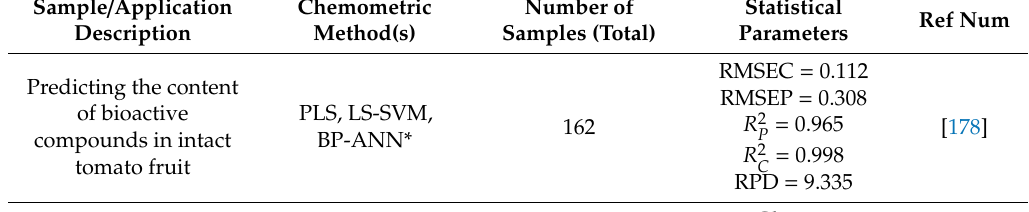
Table 8. Literature related to the use of chemometrics in prediction of properties of